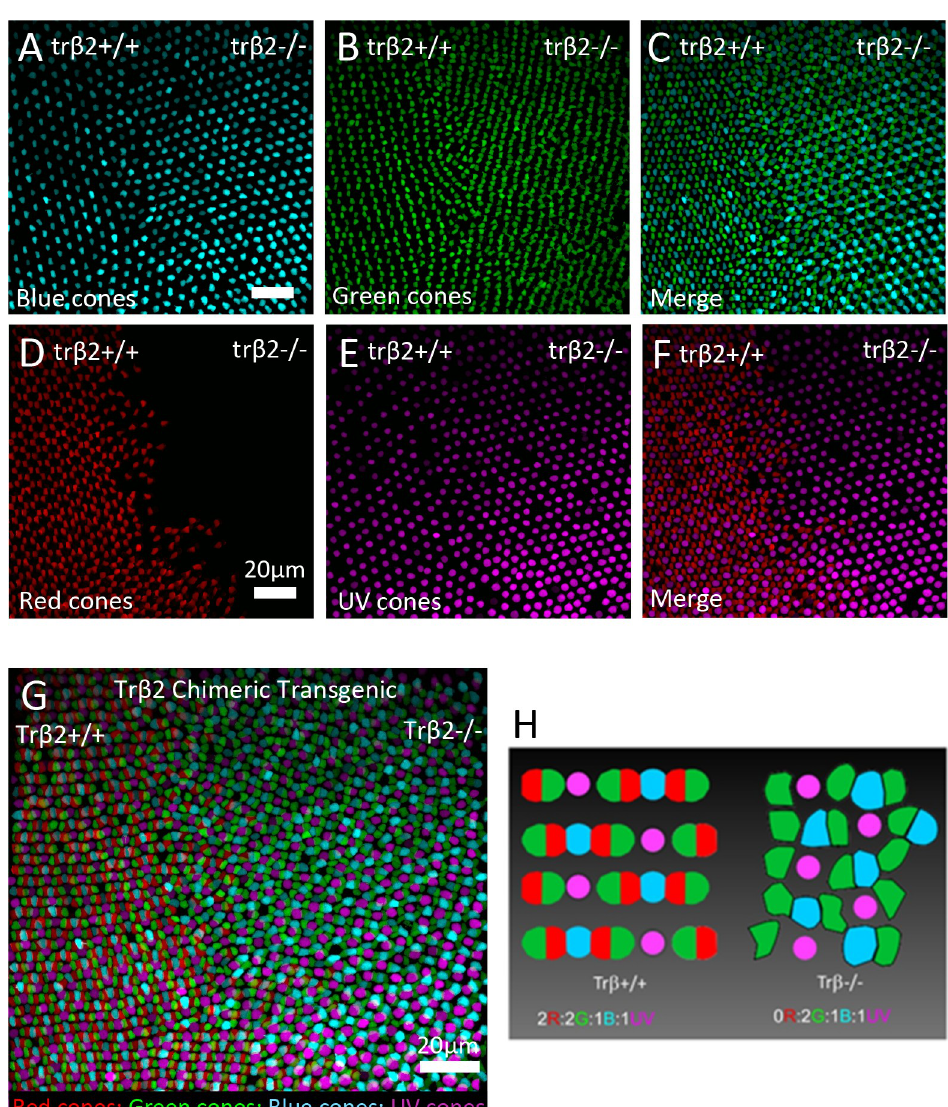
Fig 5. Mosaic analysis of cone photoreceptor spatial arrangement with CRISPR/cas9-mediated genome editing of tr β 2 . Left side of each image is either wild type or tr β 2+/- . Right side of each image is tr β 2-/- . Images show patterning of cone types separately (A, B, D, E) and merged in pairs (C, F). (G) All of the cone types are merged in this image. (H) Cone mosaic patterns in wild type/ tr β 2+/+ (left) or tr β 2-/- (right). Red cones (red), green cones (green), blue cones (blue), UV cones (magenta). Scale is the same for each image. The retina is from a 21-day fish, with the embryo injected with CRISPR/Cas9 on day 0. Images are from the same retinal location on one retina. N = 1. Since amplitude changes are not significant, datasets from individual larvae within the genetic groups were normalized to the dataset’s maximal amplitudes and combined into genotype- level datasets for fitting to the spectral model. The number of amplitude-irradiance-wave- length points in these genotype-level datasets varied from 630 for the 3BP mutants to 1190 for the combined WT group. As larvae were sequenced after physiological recording, there was no prior knowledge of genotype, so it was not possible to match the number of larvae for each genotype-level dataset.